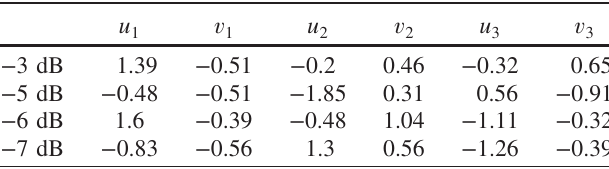
TABLE III. Summary of optimized coefficients.